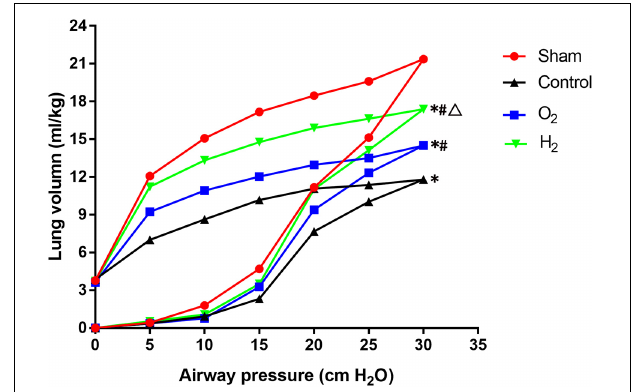
FIGURE 3 | The pressure-volume (P–V) curve in the lung graft ( n = 3). Values are means, standard deviation bars were not shown for clarity. At a pressure of 30 cmH 2 O, the lung volume in the control group was lower than the sham group ( P < 0.05), the lung volume in O 2 and H 2 groups was higher than the control group ( P < 0.05), the lung volume in the H 2 group was higher than the O 2 group ( P < 0.05). ∗ P < 0.05 vs. sham group; # P < 0.05 vs. control group; (cid:77) P < 0.05 vs. O 2 group.